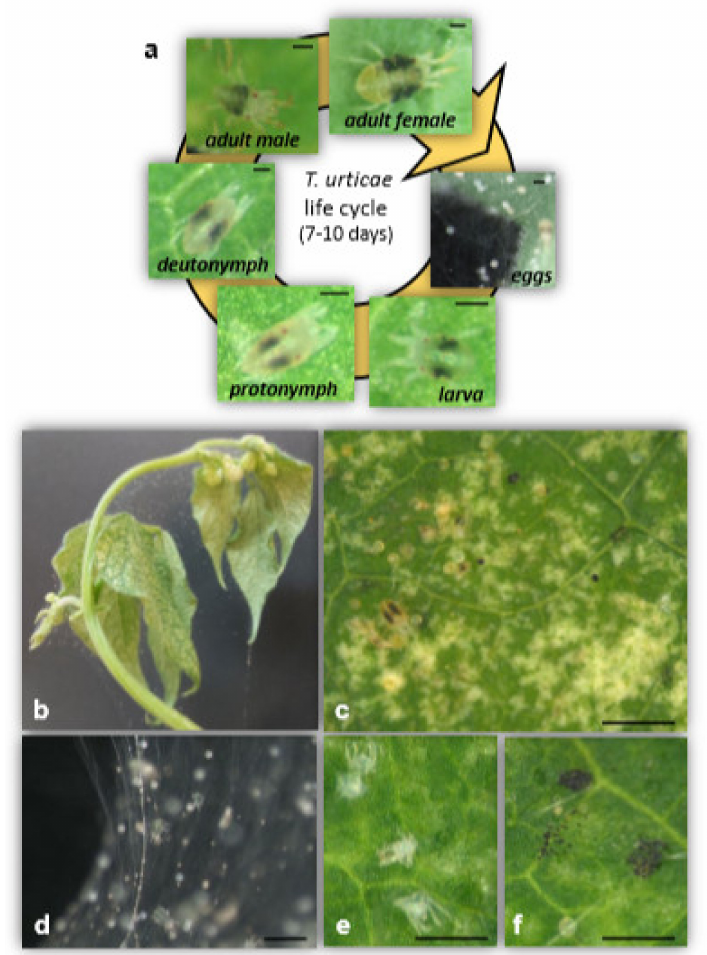
Figure 1. Phenotypic features of the plant–spider mite interaction. T. urticae life cycle ( a ), symptoms of mite-infested bean plants ( b , c ), and spider mite silk web ( d ), molts ( e ) and feces ( f ). Bar scales are indicated: 100 µ M ( a ), 500 µ M ( c ), 200 µ M ( d ) and 250 µ M ( e , f